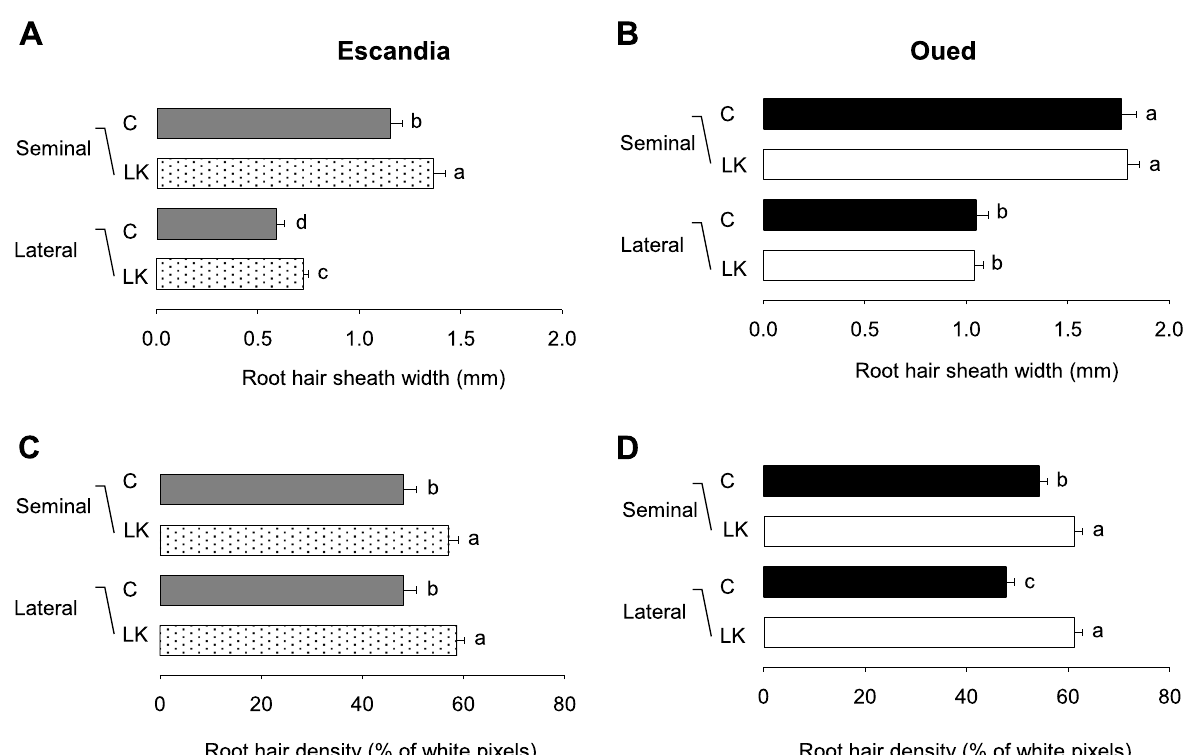
Fig. 6 Differences in local root hair elongation and density values in wheat plants grown in control or K + shortage conditions. Escandia and Oued Zenati wheat plants were grown for 14 days in rhizoboxes in control and low K + conditions (see the legend to Fig. 2). Operational estimates of root hair elongation ("root hair sheath width") and of root hair density ("root hair pixel density" along a line parallel to the root surface) were obtained from the same plants as in Fig. 4 and 5 according to the procedures described in Fig. 1D and F, respectively. Measurements were performed at 6 cm from the root tip for seminal roots, and at the middle of lateral roots, over 4 mm root segments in both cases. Segments from 4 seminal roots and 4 lateral roots from different seminal roots were analyzed per plant. A, B Root hair sheath width in Escandia ( A ) and Oued Zenati ( B ) seminal and lateral roots of plants grown under control or low K + conditions. C, D Root hair (white pixels) density in Escandia ( C ) and Oued Zenati ( D ) seminal and lateral roots of plants grown under control or low K + conditions. Means SE ( n 40 from 10 plants for control condition and 56 from 14 ± = plants for low K + condition in Escandia; n 56 from 14 plants for both conditions in Oued Zenati). Different letters denote statistically significant = differences (One way anova test, p < 0.05) between the values in control condition and the corresponding values in K + shortage condition, and between values in seminal and lateral